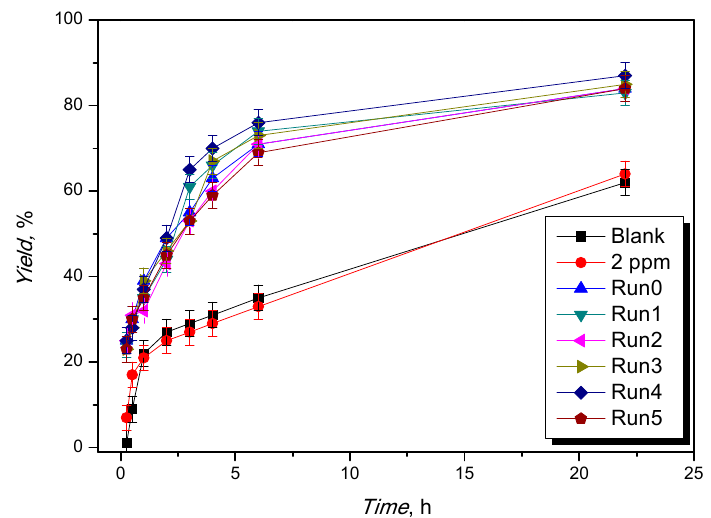
Figure 4. Evolution of the yield to ketal vs. the reaction time for different reuses. Operative conditions: T = 120 ◦ C, ethyl levulinate:glycerol = 1:1 mol/mol, catalyst loading = 1%, in moles, with respect to glycerol.